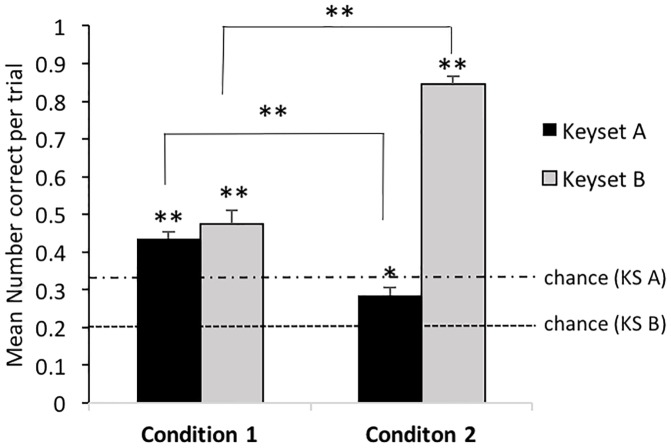
Selection: Mean number of correct choices per trial.Keyset A (black columns) and B (grey columns). Chance expectation for keyset A = 0.33; for keyset B = 0.2 correct per trial. * chosen above chance expectation; ** p<0.0001.